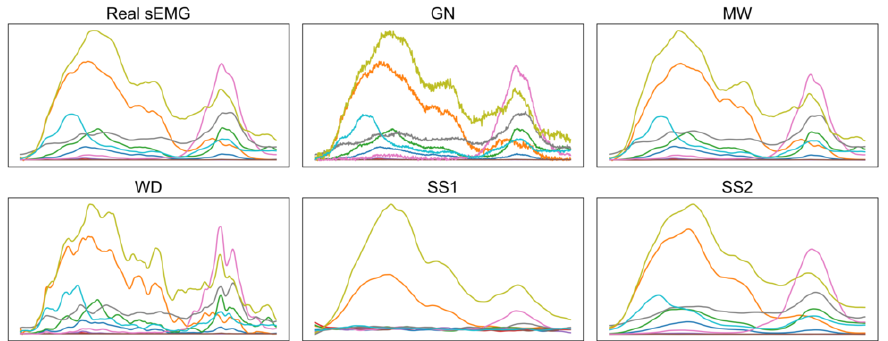
Figure A2. Examples of the investigated augmentation methods applied to the RMS of a sEMG signal from Ninapro-DB1. The colors correspond to the different electrode channels.